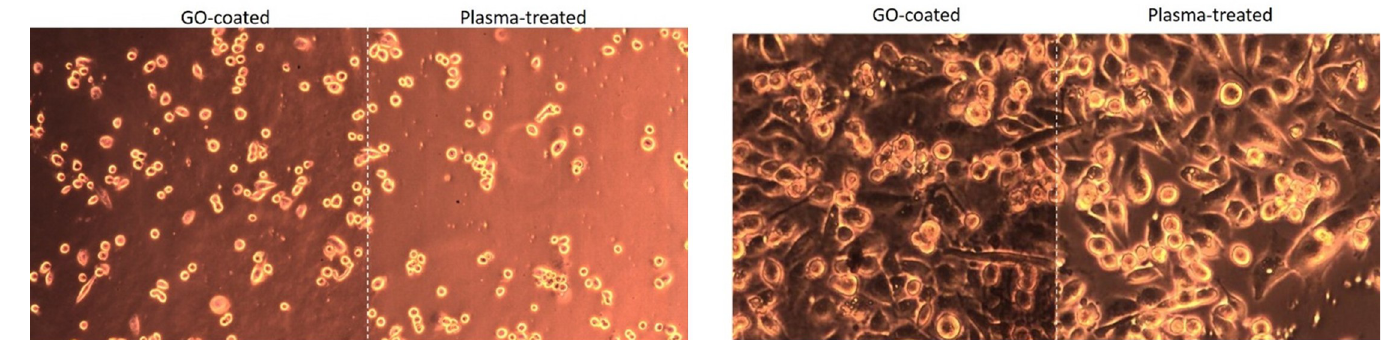
Fig 8. MDA-MB-231 cancer cells cultured on GO-coated and plasma-treated COC substrate (a) after 12 hours of seeding and (b) after five days of seeding.